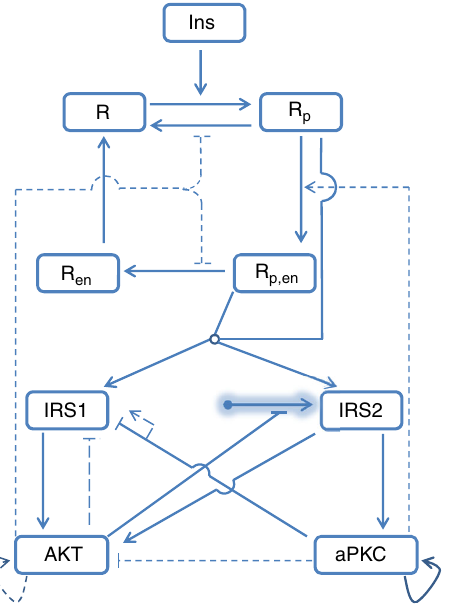
Fig. 1 Scheme of the mathematical model. Insulin (Ins) induces insulin receptor (R) phosphorylation (R p ), which then undergoes internalization (R p,en ), dephosphorylation (R en ) and reinsertion into cell membrane (R). Phosphorylated insulin receptors (both R p and R p,en ) activate IRS1 and IRS2, which both activate Akt. Only IRS2 activates aPKC. Synthesis of IRS2 (shadowed arrow with round end) is subject to inhibition induced by AKT. Both, AKT and aPKC have positive auto-feedback. aPKC inhibits IRS1 and AKT activity. Broken lines indicate feedbacks that have been suggested in the literature but are dispensable for data fi tting. Shadowed arrows with round ends indicate that the synthesis and degradation of the pointed element are considered in the model. The open circle at the place of merging lines indicates shared downstream